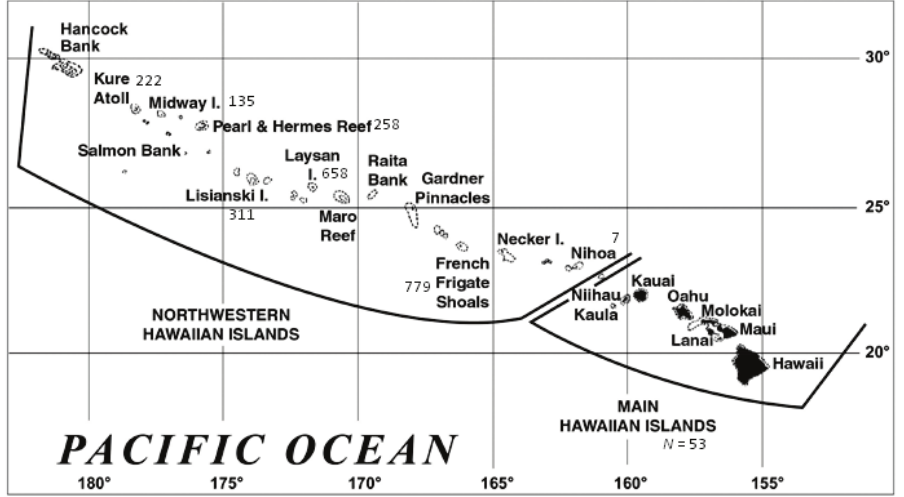
Figure 1. The Hawaiian archipelago (www.noaa.gov). Numbers reflect the genetic sample size from each